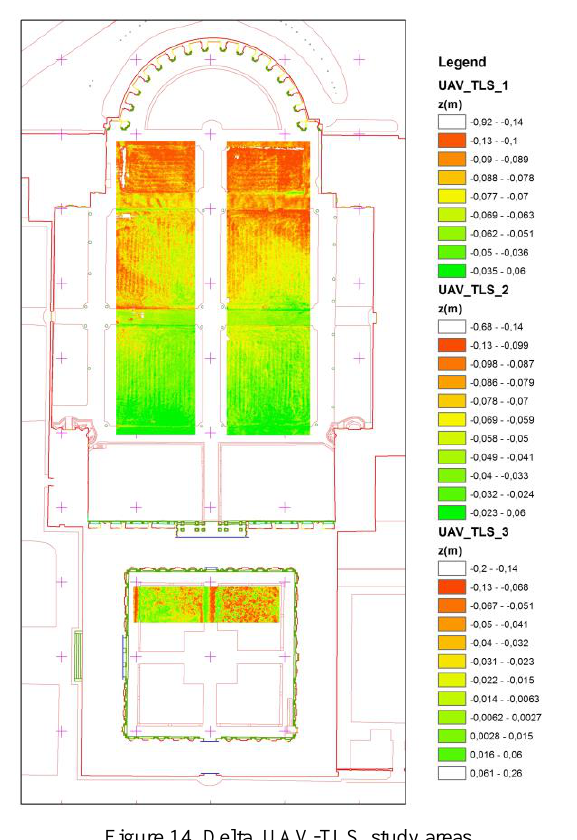
Figure 14. Delta UAV-TLS, study areas.